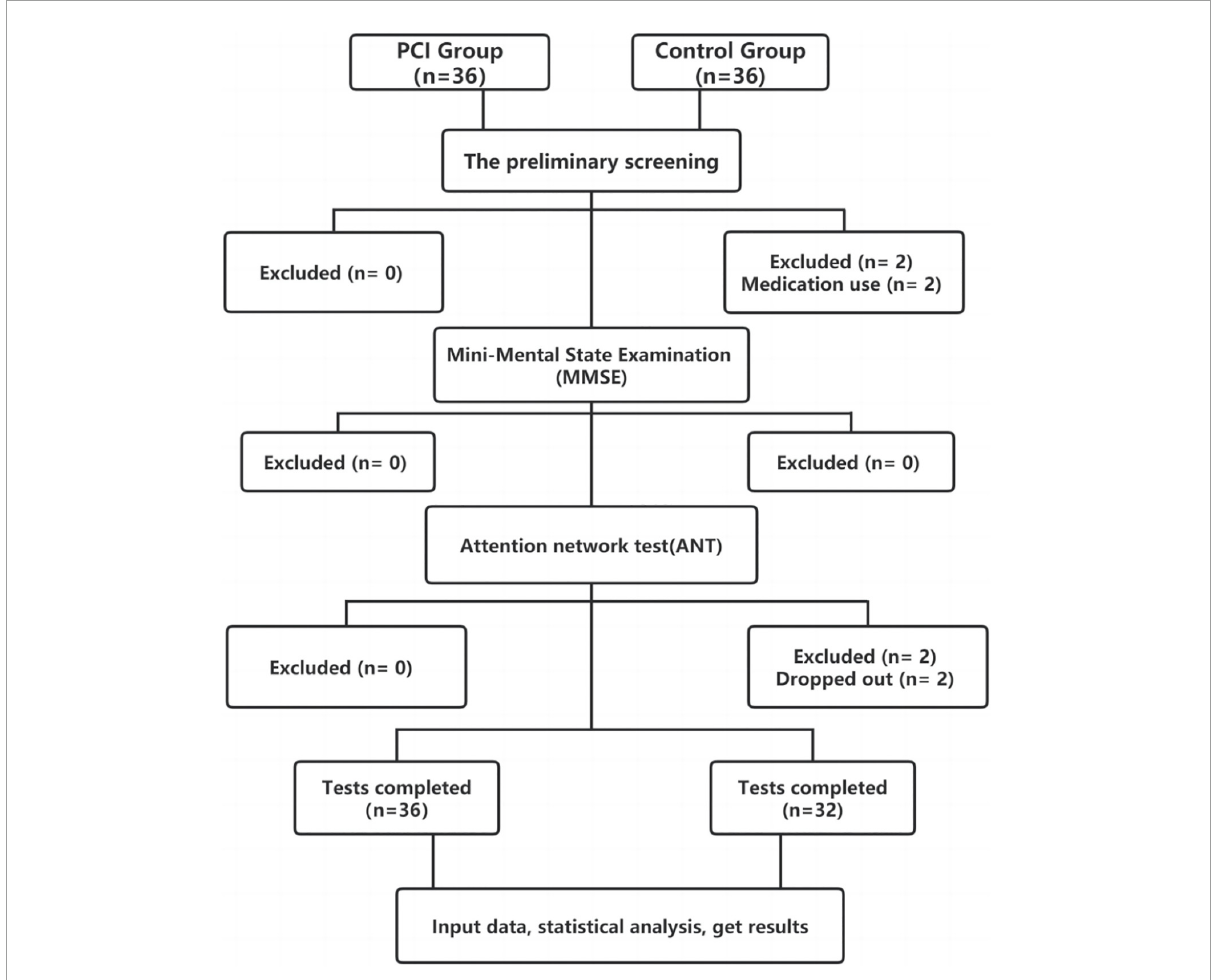
FIGURE2 Chart illustrating the participant flow and the reasons for exclusion/withdrawal in the posterior circulation ischemia (PCI) and control